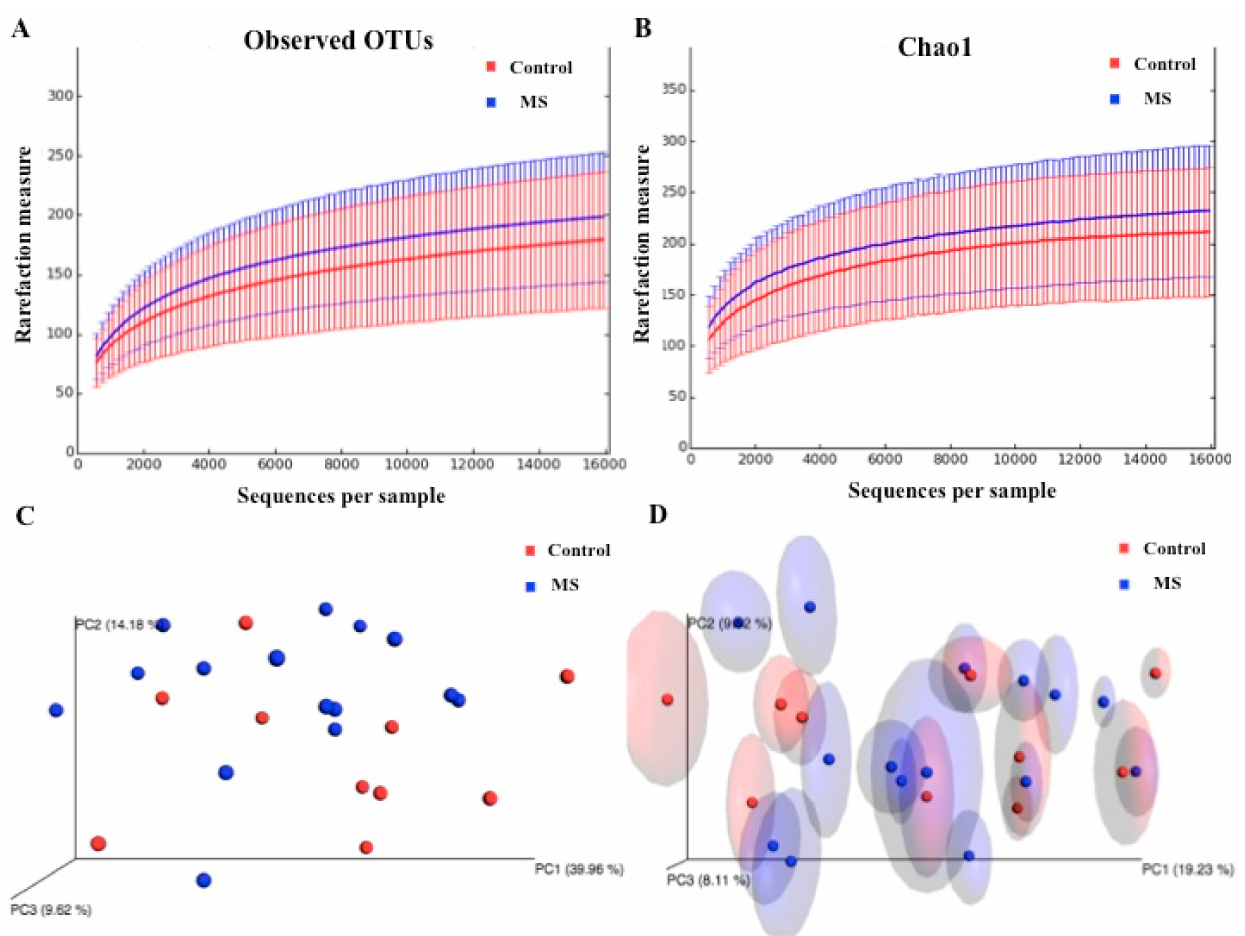
Figure 1. Alpha and beta diversity in the gut microbiota of RRMS patients receiving DMTs and that of healthy controls. Rarefaction curves are a representation of species richness for a given number of individual samples: ( A ) Observed and ( B ) Chao 1-estimated OTUs. Principal component analysis (PcoA) is a transformation of weighted or unweighted Unifrac distance, a pair-wise distance between samples based on the calculation of the shared branches of the phylogenetic tree of the representative rRNA genes from OTUs present in at least one sample: ( C ) PcoA plot with weighted and ( D ) unweighted UniFrac metric with Bonferroni’s